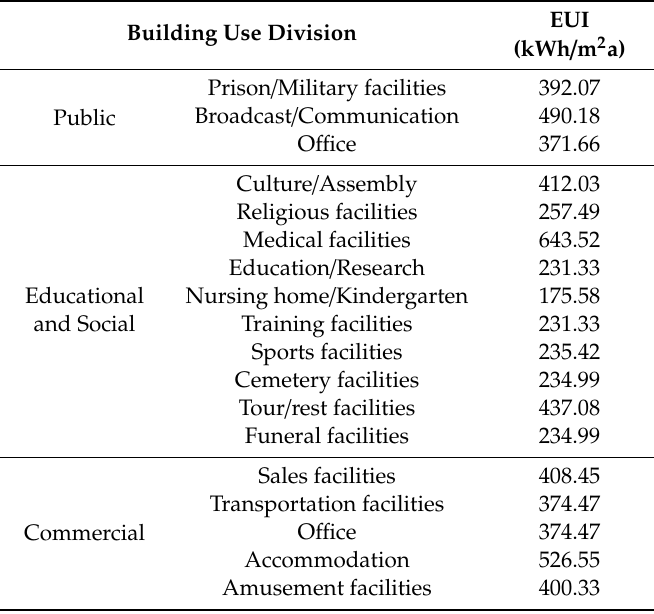
Table 5. Average Energy use intensity (EUI) by building use in Korean regulations.